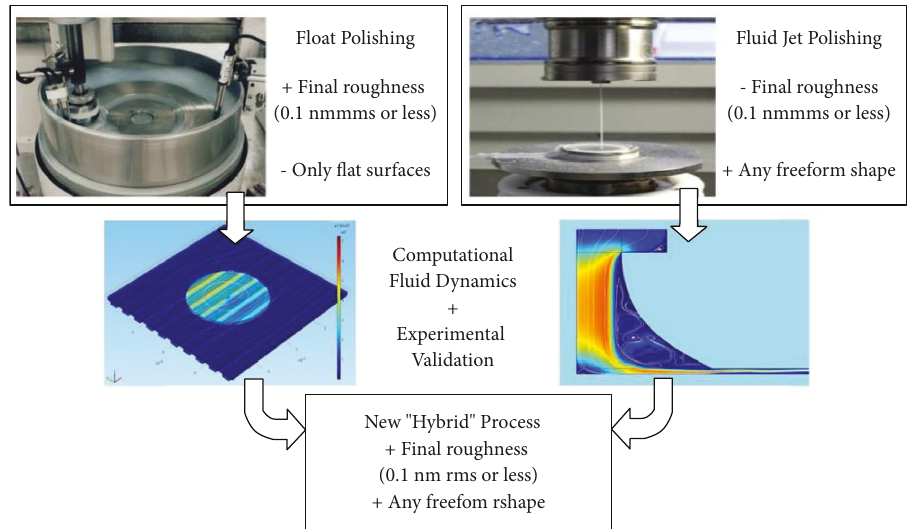
Figure 14: Proposed plan for a novel “hybrid” finishing process